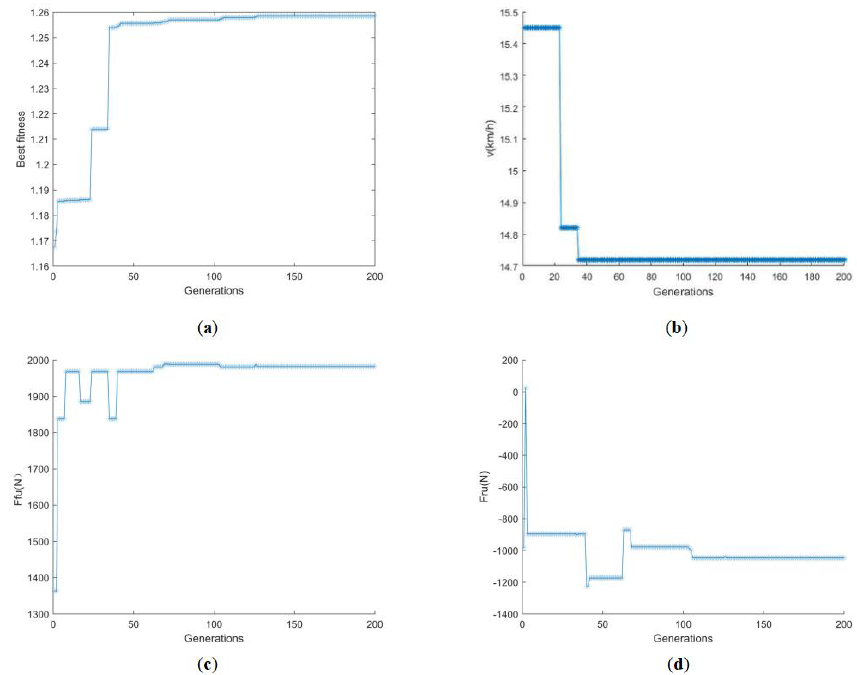
Figure 9. The iterative process of each variable of the active suspension vehicle. (a) All individuals’ optimal fitness. (b) Optimal individual’s v . (c) Optimal individual’s F fu . (d) Optimal individual’s F ru .